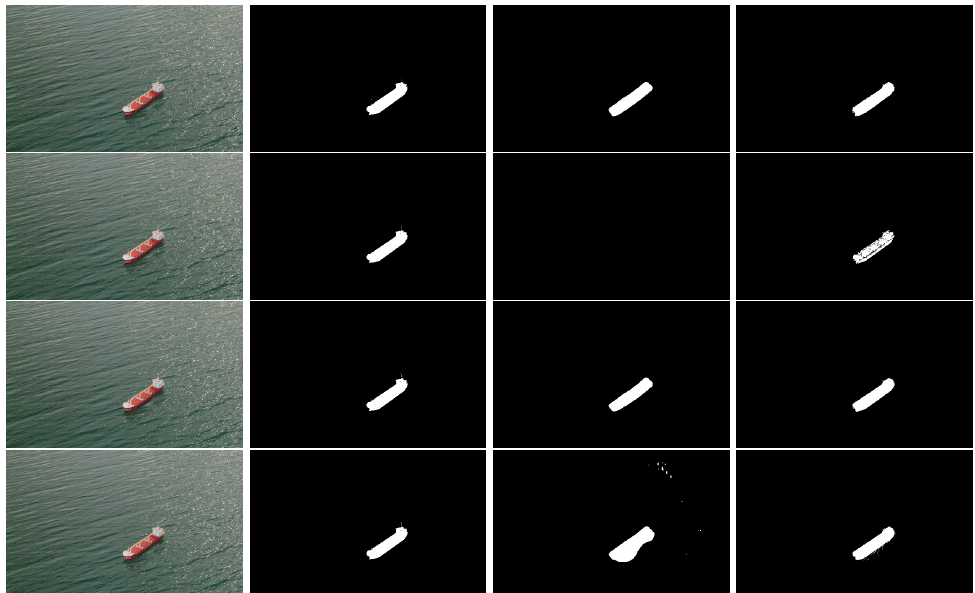
Figure 12. Simulated frame loss on the MarSyn dataset. First column: original images taken from a video sequence, from older (top) to newer (bottom); second column: corresponding ground truth masks; third column: Yolact++ segmented images, where the loss of the second frames of the sequence is simulated; fourth column: final segmentation result after post-processing with the 3D